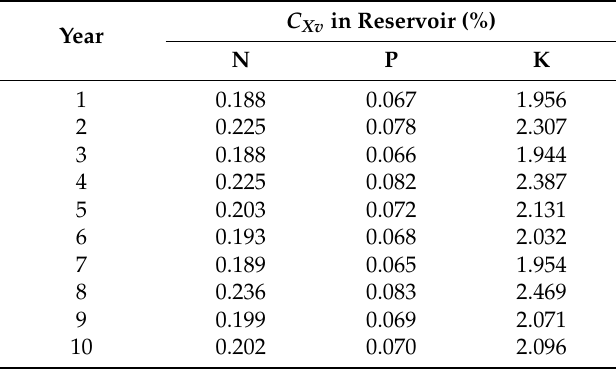
Table 5. Calculated concentrations of total N, P, and K in reservoir sediments.